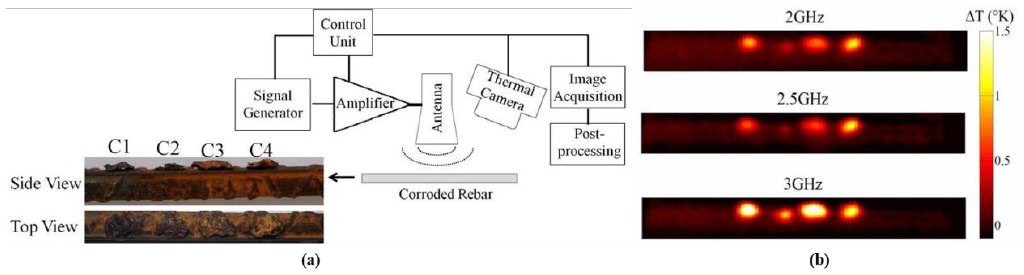
Figure 5. ( a ) MWT measurement setup for corroded rebar detection; ( b ) temperature profile for corroded steel bar [62]. Reprinted/reproduced with permission from IEEE.